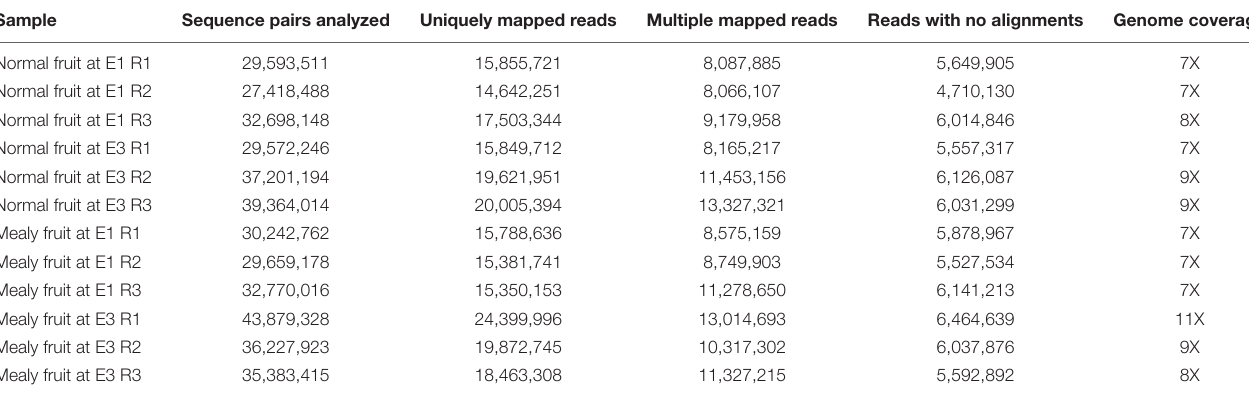
TABLE 1 | Parameters of Prunus persica whole genome bisulfite sequencing and mapping of each sample and condition.